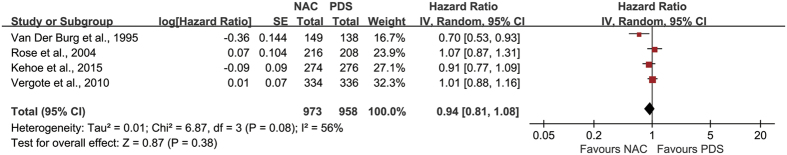
Forest plot for overall survival.NAC, neoadjuvant chemotherapy followed by interval debulking surgery; PDS, primary cytoreductive surgery followed by systemic chemotherapy.